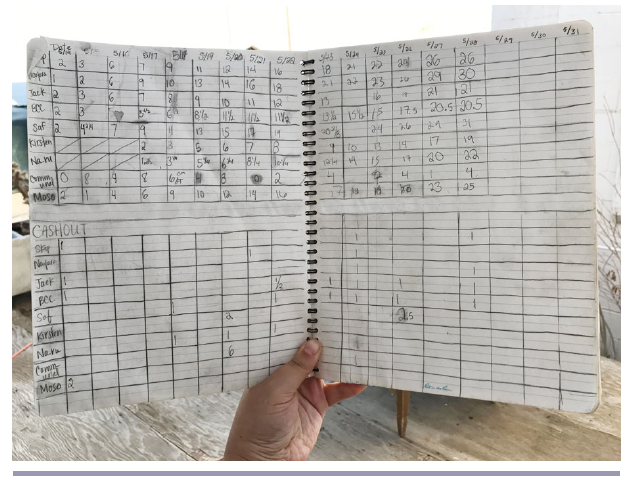
Fig. 3. Water distribution at the water tank. Fig. 4. Log book of water distribution. Numbers (in gallons) show that when < 4 gallons/day were used, the excess was “banked” for each